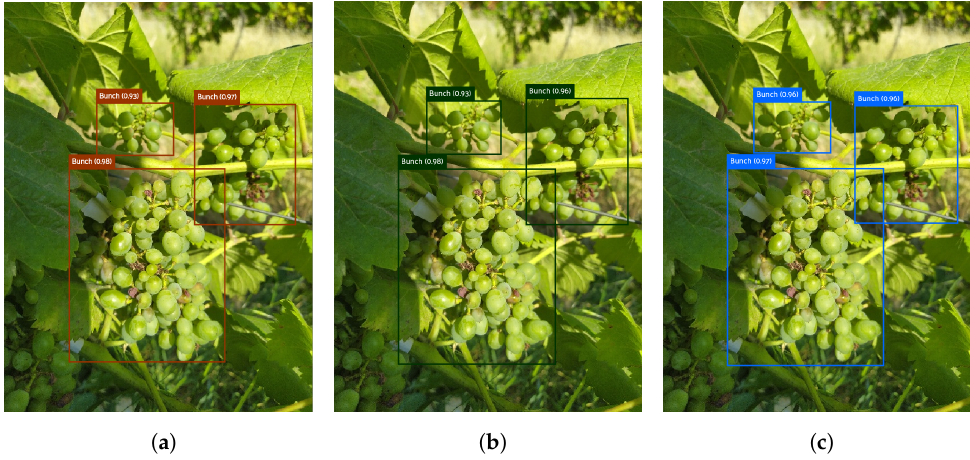
Figure 4. Detection of grape bunches in samples from the test set. Red bounding boxes present the predictions from YOLOv5. Green bounding boxes present the predictions from YOLOv7. Blue bounding boxes present the predictions from YOLOR. ( a ) YOLOv5. ( b ) YOLOv7. ( c )